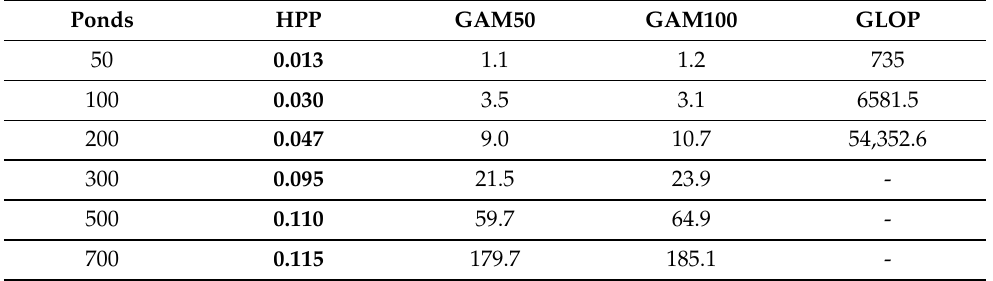
Table 3. Average Run Time (ms).